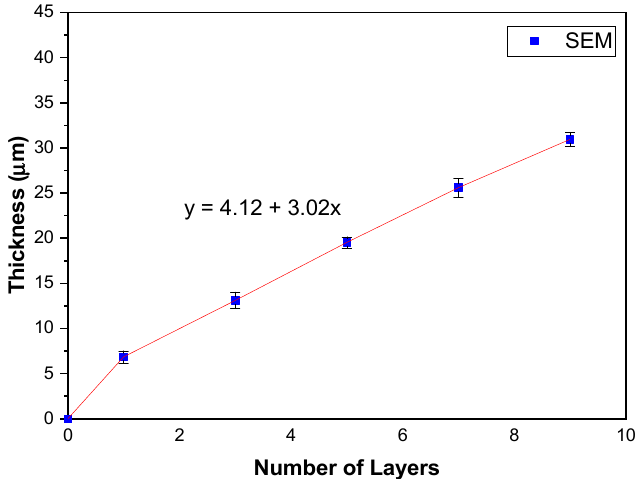
Figure 3. Thickness of 9SFT-1SDC composite cathode deposited on SDC electrolyte.